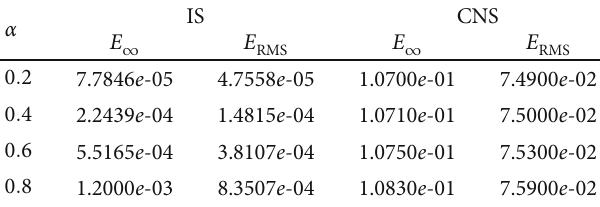
Table 3: Comparison with of E